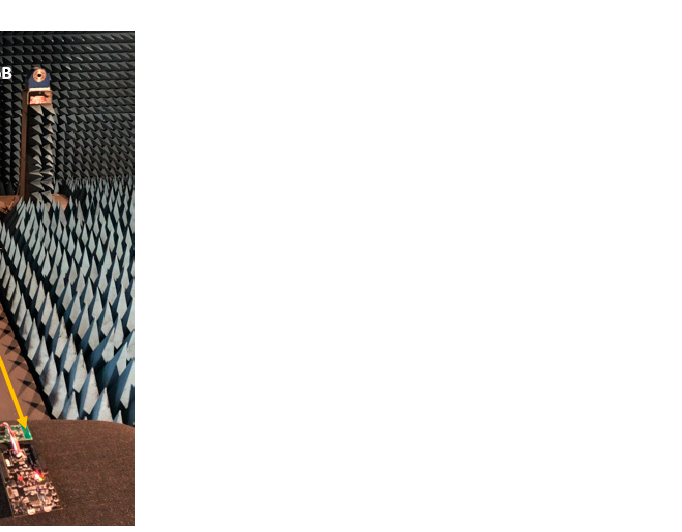
Figure 2. The BLE devices used in our experiments. These devices were designed in the context of the same project; they are different versions of the same product whose hardware and software architectures have evolved over time. Thus, v1 (the board at the left end) refers to the first ever version; v2 (the two boards in the middle) and v3 (the two boards at the right end) refer to the second and third versions, respectively.